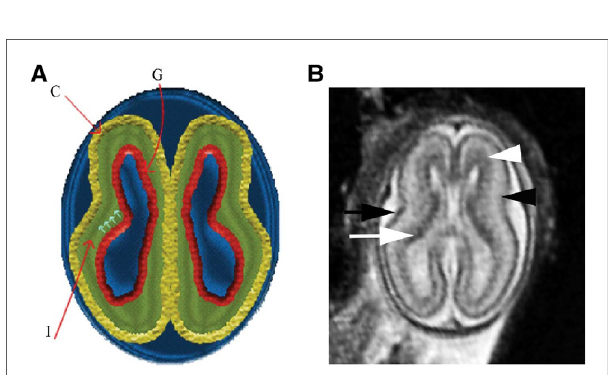
FIGURE 6 Normal multilayered magnetic resonance imaging (MRI) appearance of fetal brain early in gestation (72). ( A ) A diagram representing the fetal brain at 19 weeks of gestation shows smooth surface and multilayered appearance of the parenchyma with an inner germinal matrix (G), intermediate layer (I), and a developing cortex ( C ). The small arrows point to the direction of the migrating neurons from germinal matrix to the developing cortex. ( B ) Axial balanced fast fi eld echo MR image of a normal brain at 19 weeks of gestation shows a smooth surface and multilayered parenchyma with an inner hypointense germinal matrix (white arrow), an intermediate layer, and an outer hypointense developing cortex (black arrow). Two additional sublayers can be identi fi ed: subventricular zone (white arrowhead) and subplate (black arrowhead). Subventricular zone is thick in the frontal region and shows slightly hypointense signal as it contains germinal matrix with increased cell production. The subplate zone appears slightly hyperintense as it has high water content because of extracellular